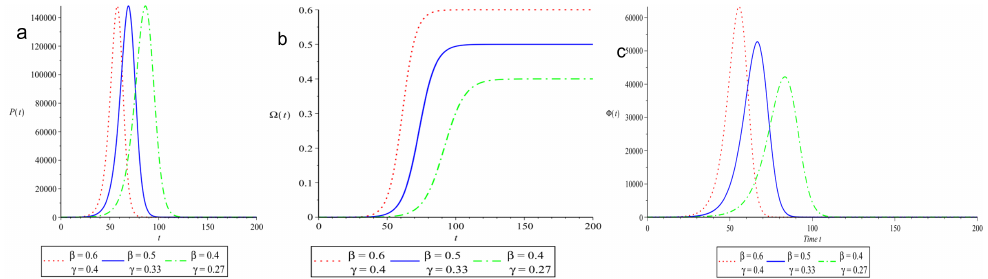
Figure 3. The behavior of EP, FOI and ROI for varying β and γ (with a fixed reproduction number ρ = 1.5). We used S ( 0 ) = 10 6 − 5, A ( 0 ) = 2, I ( 0 ) = 3, Q ( 0 ) = 0, N = 10 6 and 0 ≤ t ≤ 200. The parameters are measured in (day − 1 ) . The time t is taken on the horizontal axis and is measured in days.